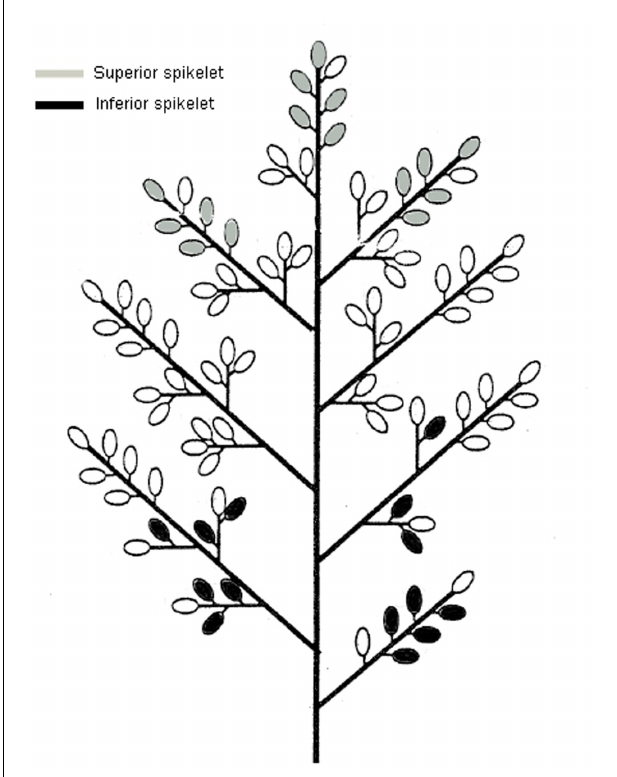
FIGURE 1 | Diagrams of the spikelets on the rice panicle (Kikuya et al., 2001 with some modifications). The spikelets shown in gray represent the location of superiors and those shown in black represent the location of inferior